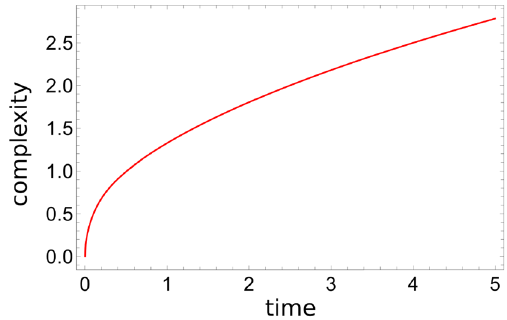
Fig. 12 Complexity of single time evolved target state for inverted oscillator ( m = 1 ,λ =